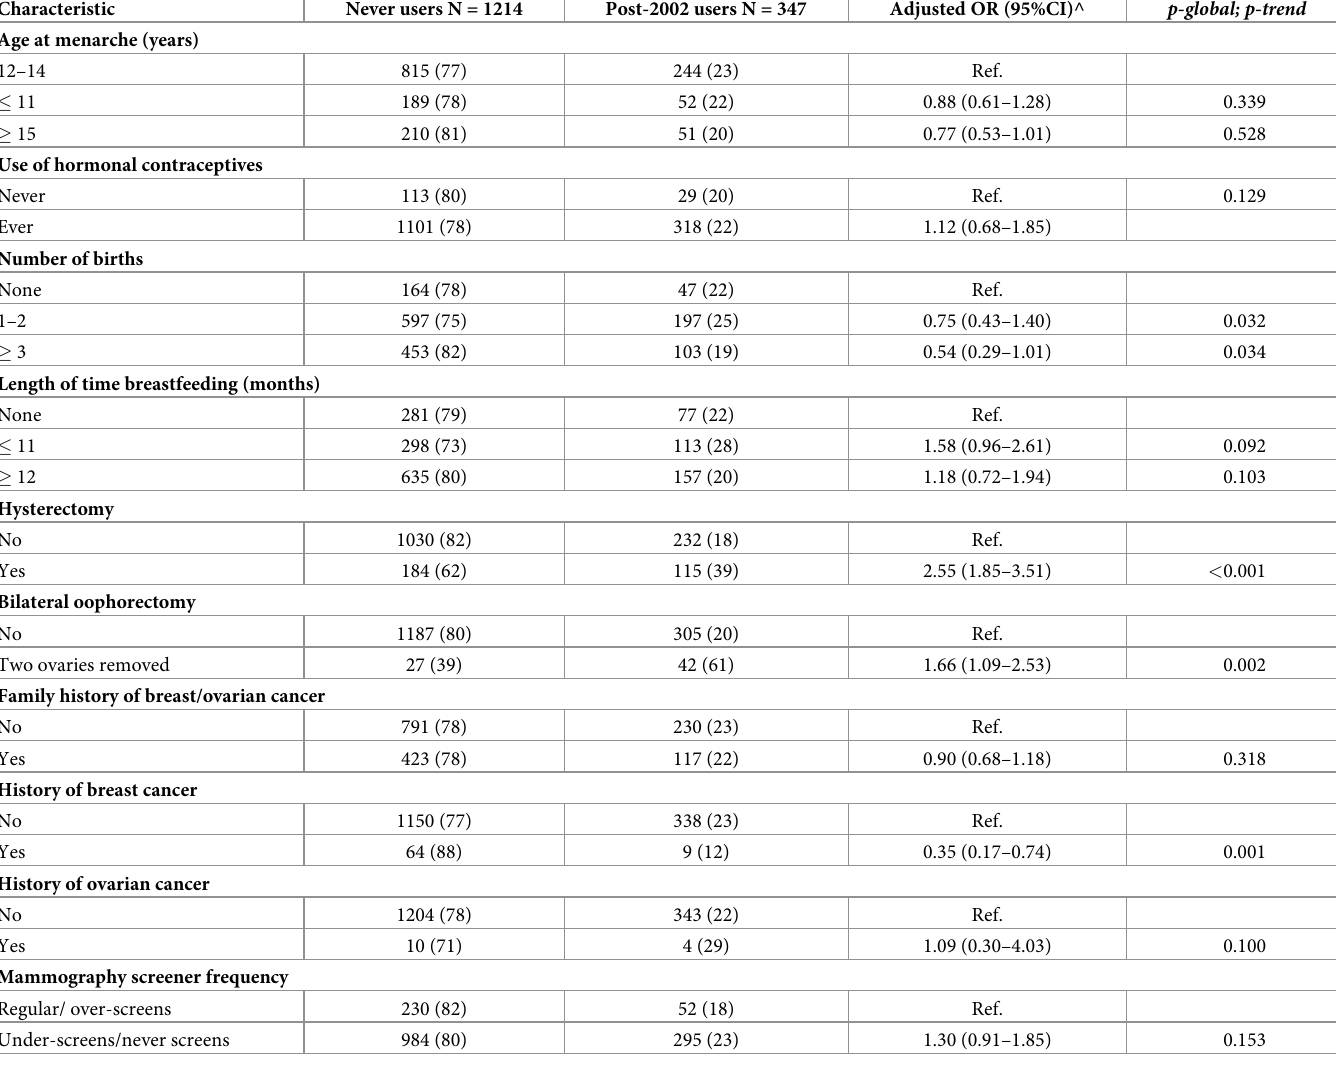
Table 2. Associations of reproductive/health-related characteristics and menopausal hormone therapy use between users initiating MHT after 2002 and never users (younger than 50 in 2002) among Australian women aged 50–69 years old.